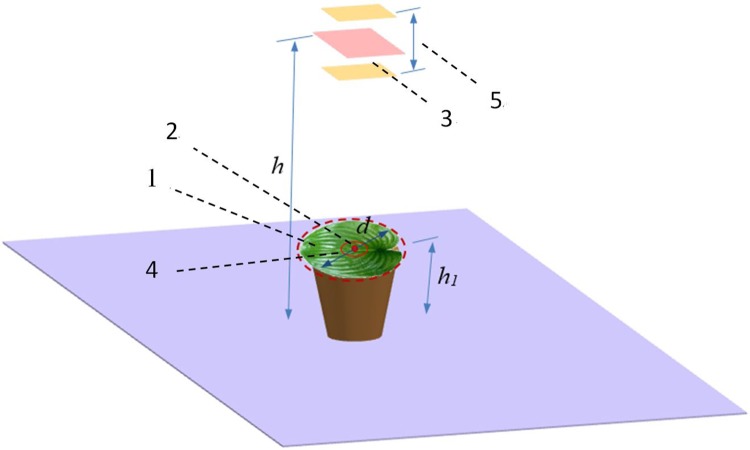
Schematic diagram of target and tracking effects.1. Blade 2. Centroid (horizontal expected position) 3. Vertical desired position. 4,5. Horizontal and vertical range of effective target tracking.